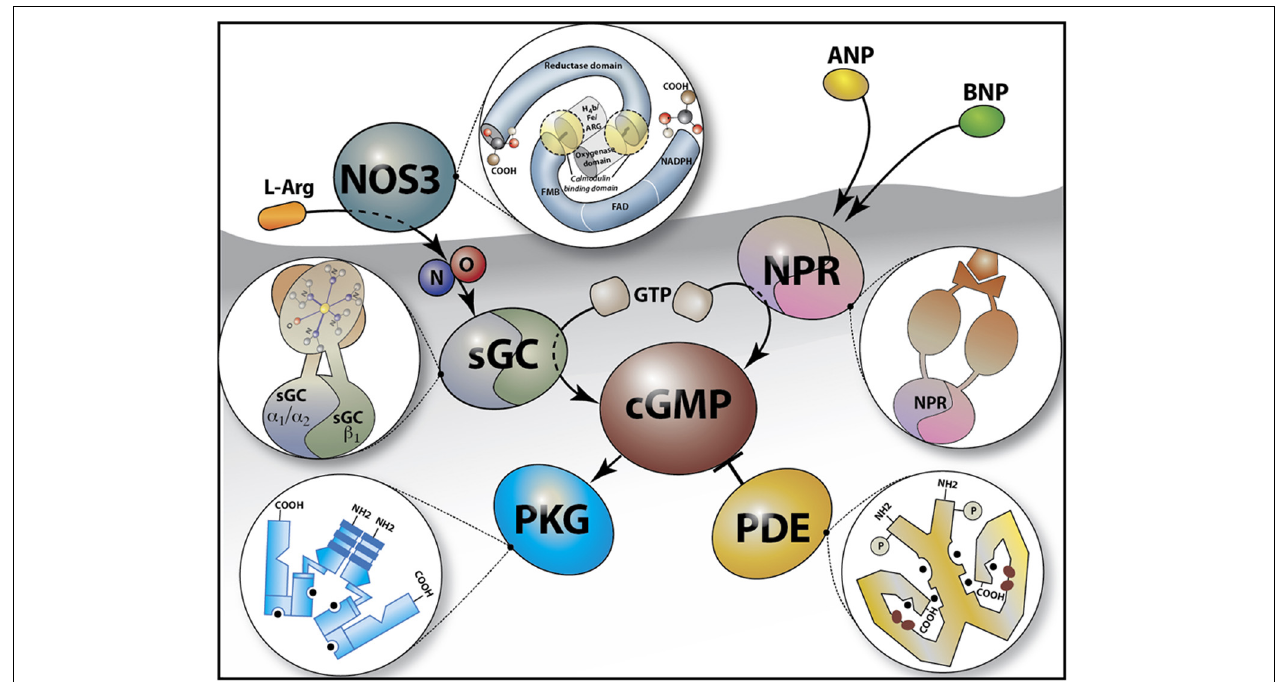
FIGURE 1 | Schematic of the Cyclic GMP (cGMP) signaling pathway. cGMP is synthesized from GTP by soluble guanylate cyclases (sGC α 1 β 1 or sGC α 2 β 1 ) in response to nitric oxide (NO) e.g., as generated by the conversion of L-arginine (L-Arg) by NO synthase 3 (NOS3), or by the membrane guanylate cyclase (natriuretic peptide) receptors (NPR) which are activated by peptide